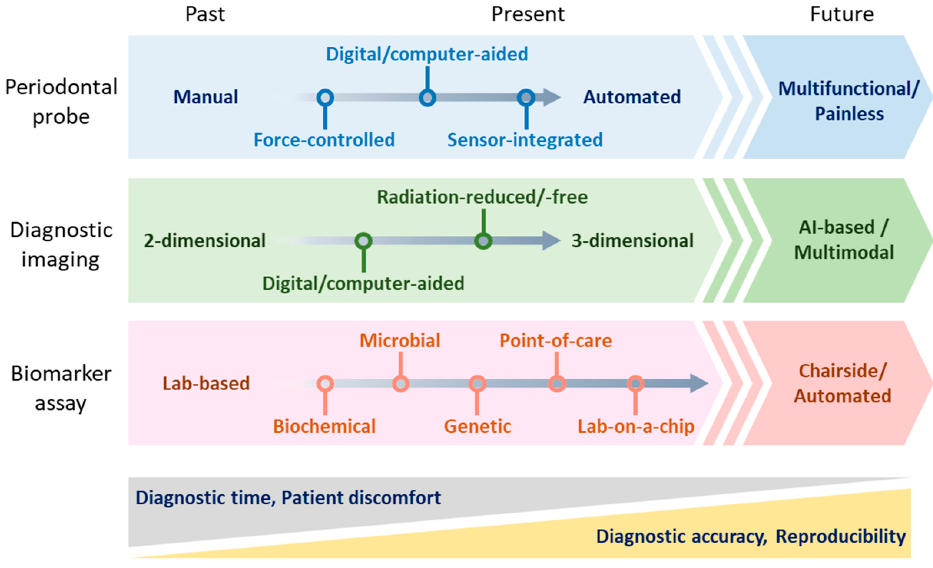
Figure 3. Advancement of chairside periodontal diagnostic tools and their future directions.